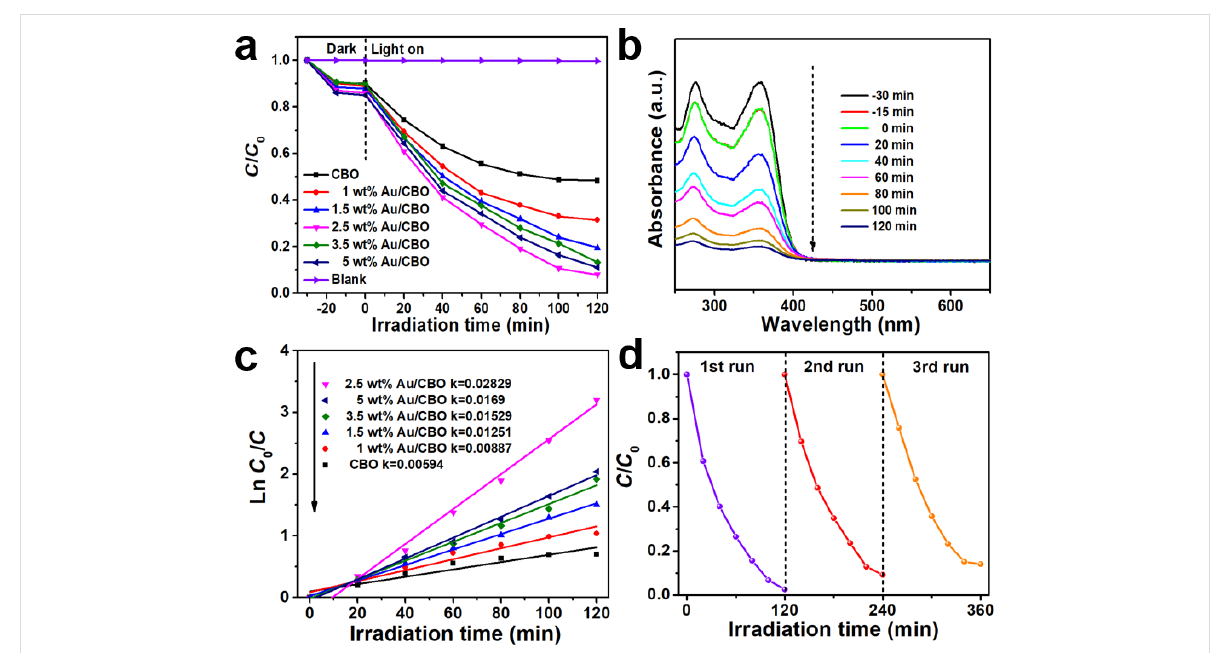
Figure 6: (a) TC degradation dynamics under visible-light irradiation. (b) Changes of the characteristic absorption of TC when using 2.5 wt % Au/CBO as a photocatalyst. (c) First-order kinetics of the TC degradation curves using different photocatalysts. (d) Three consecutive runs of TC degradation over 2.5 wt % Au/CBO